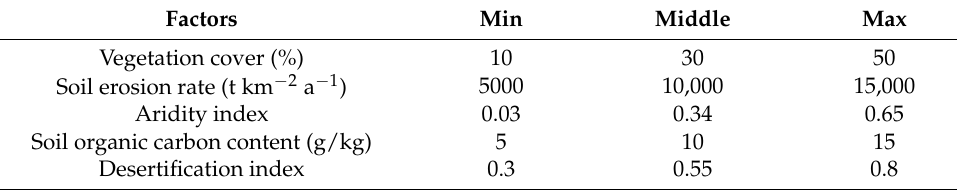
Figure 4. Fuzzy membership of factors. ( a ) The membership of vegetation degradation, aridity and loss of soil organic carbon. ( b ) The membership of soil erosion and desertification. Table 2. Factors and their suitable ranges.